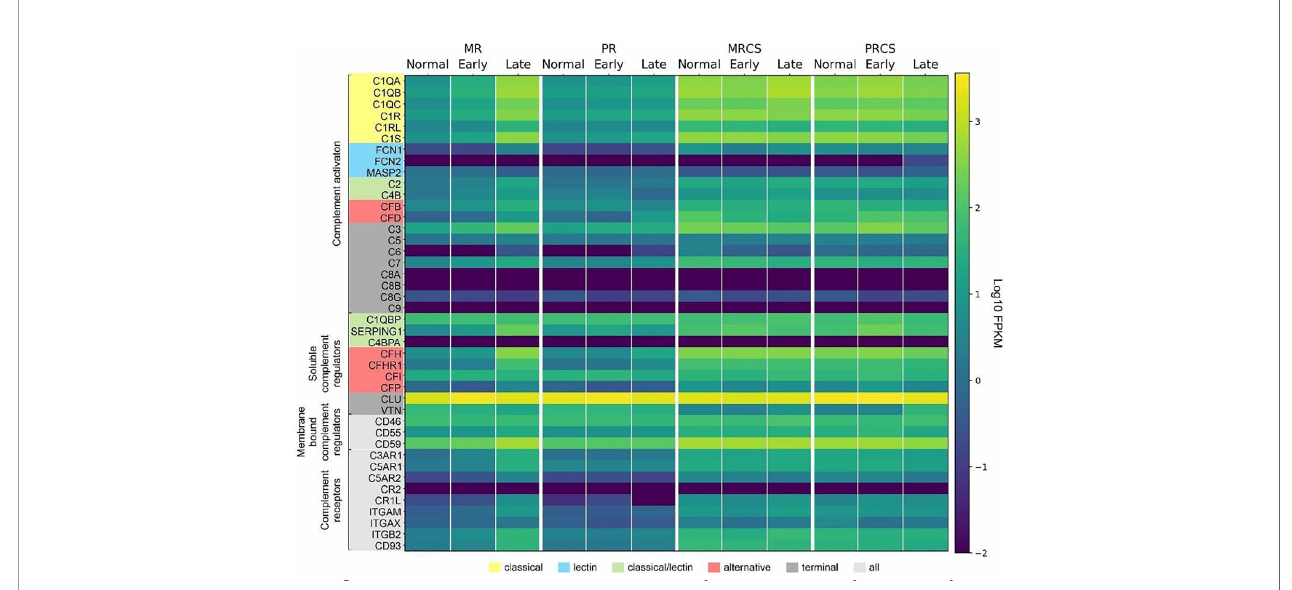
FIGURE 9 | Heat map of complement gene expression determined using bulk RNA-seq for macular retina (MR), peripheral retina (PR), macular RPE/choroid/sclera (MRCS) and peripheral RPE/choroid/sclera (PRCS) from normal, early AMD and advanced AMD donors. Expression is measured in units of FPKM and color-coded on a logarithmic